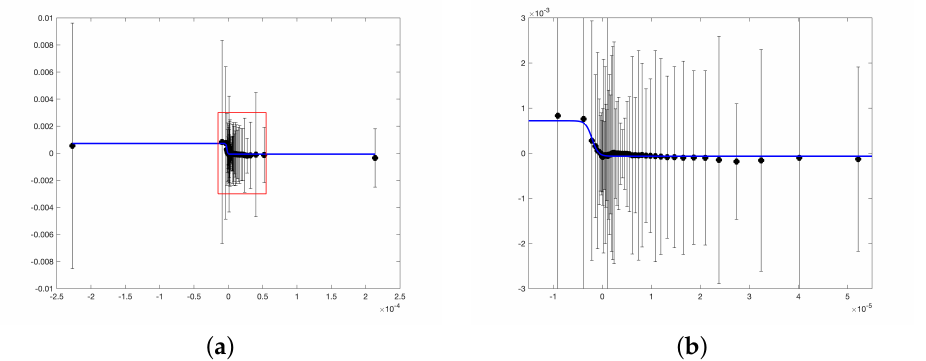
(cid:12) (cid:12) on the parameter ∂ρ (kg/m 4 ) in cluster A: (cid:12) ∂ (cid:126) n σ ( q ) H